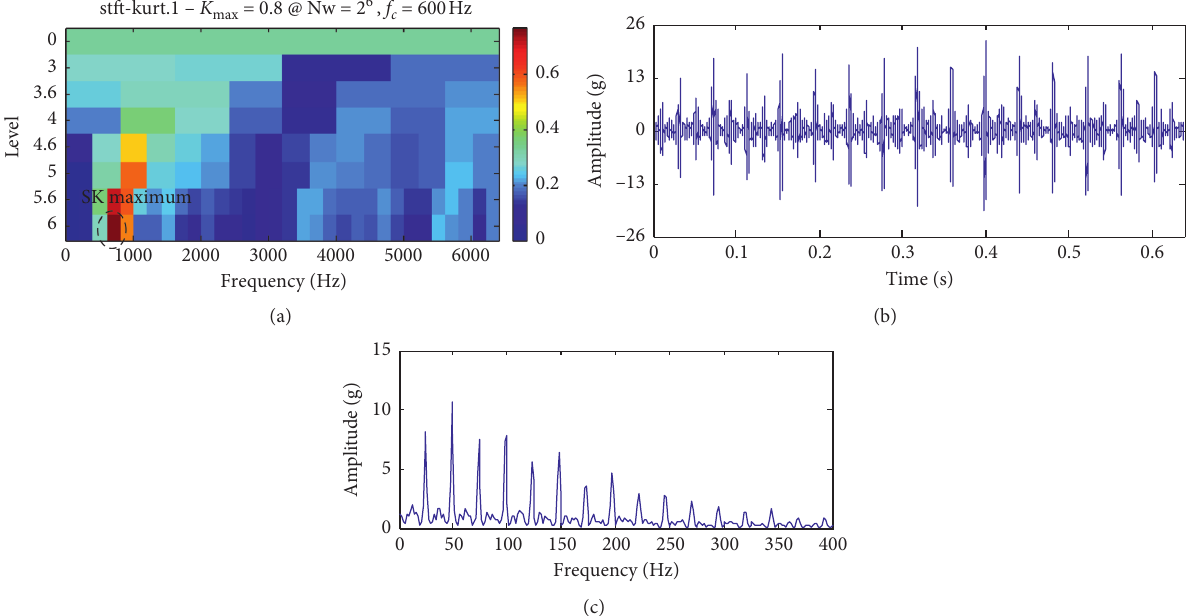
Figure 18: Comparison results of experimental signal by the SK method: (a) the kurtogram; (b) the waveform of filtered signal; (c) the envelope spectrum of filtered